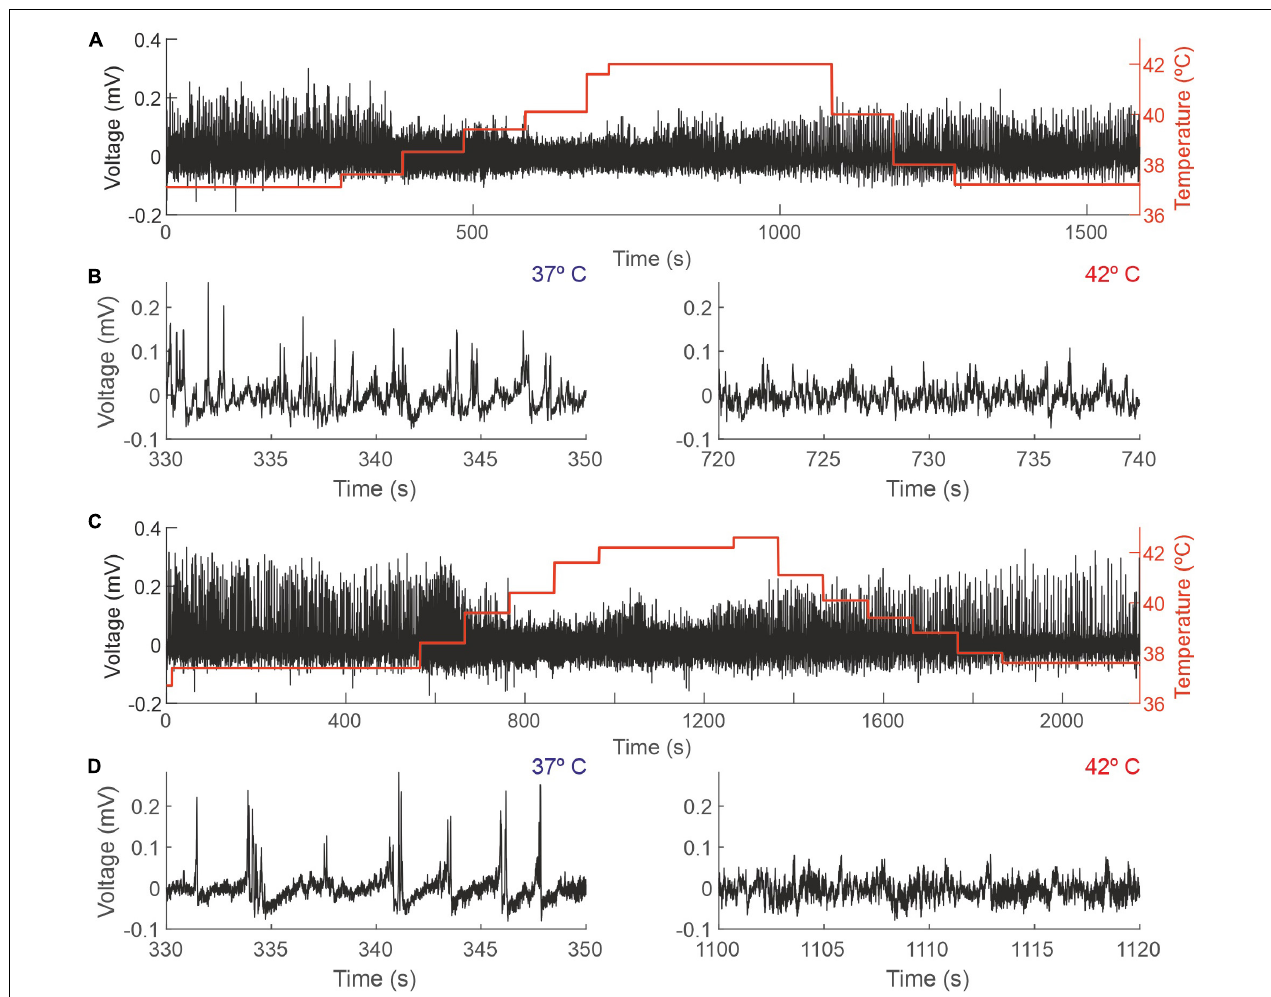
FIGURE 3 | Changes in the EEG as a function of the core temperature recorded from two different mice. (A,C) Raw EEG data (black trace, left y-axis) and core temperature (red trace, right y-axis). (B,D) Details from the recordings depicted in panels (A,C) , respectively, showing 20 s during which the temperature of the mouse was 37 ◦ C (left panels) and 42 ◦ C (right